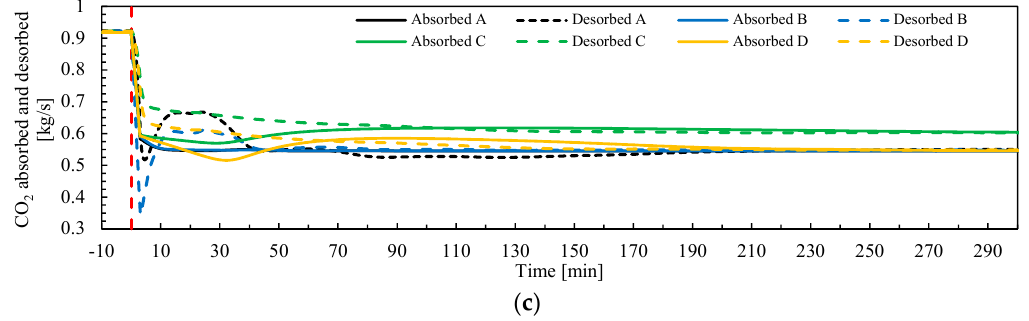
Figure 10. Outputs from pilot plant model during simulations for load change ramp-down (Test 1)